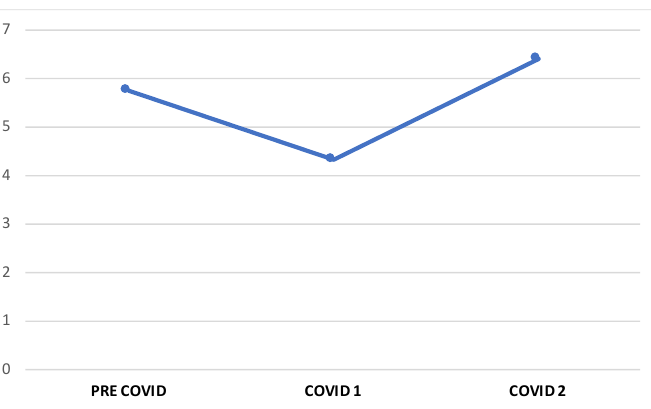
Figure 2. Average number of migraine episodes in the ore-COVID and COVID-19 periods.